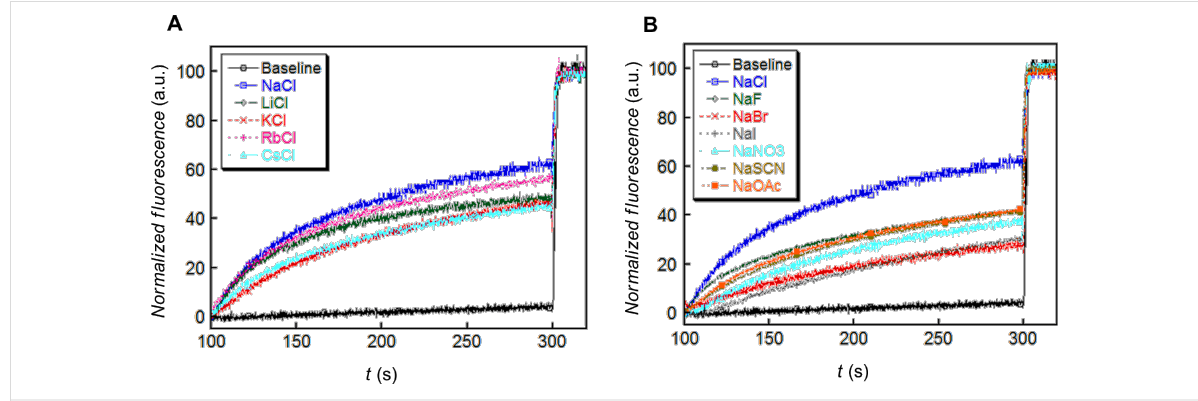
Figure 7: Cation (A) and anion (B) transport activity of 2a .